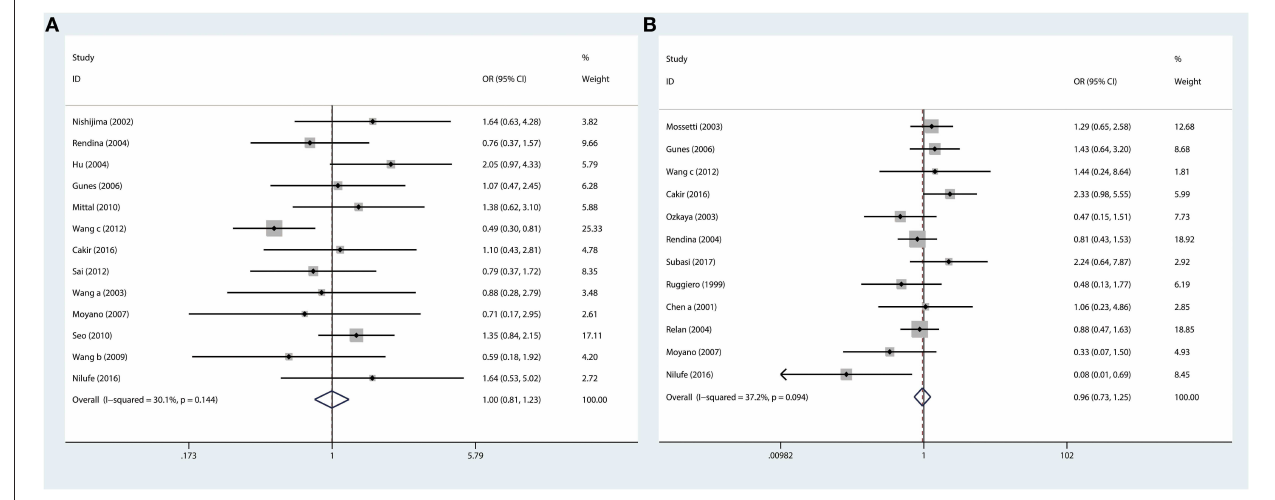
FIGURE 3 | Forest plots of VDR TaqI variant and urolithiasis: (A) overall for ApaI AA vs. aa and (B) overall for BsmI BB vs.